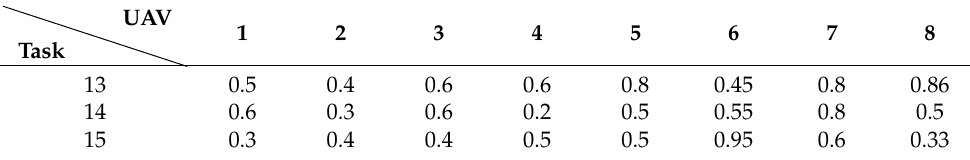
Table 9. UAV stealth capability information.